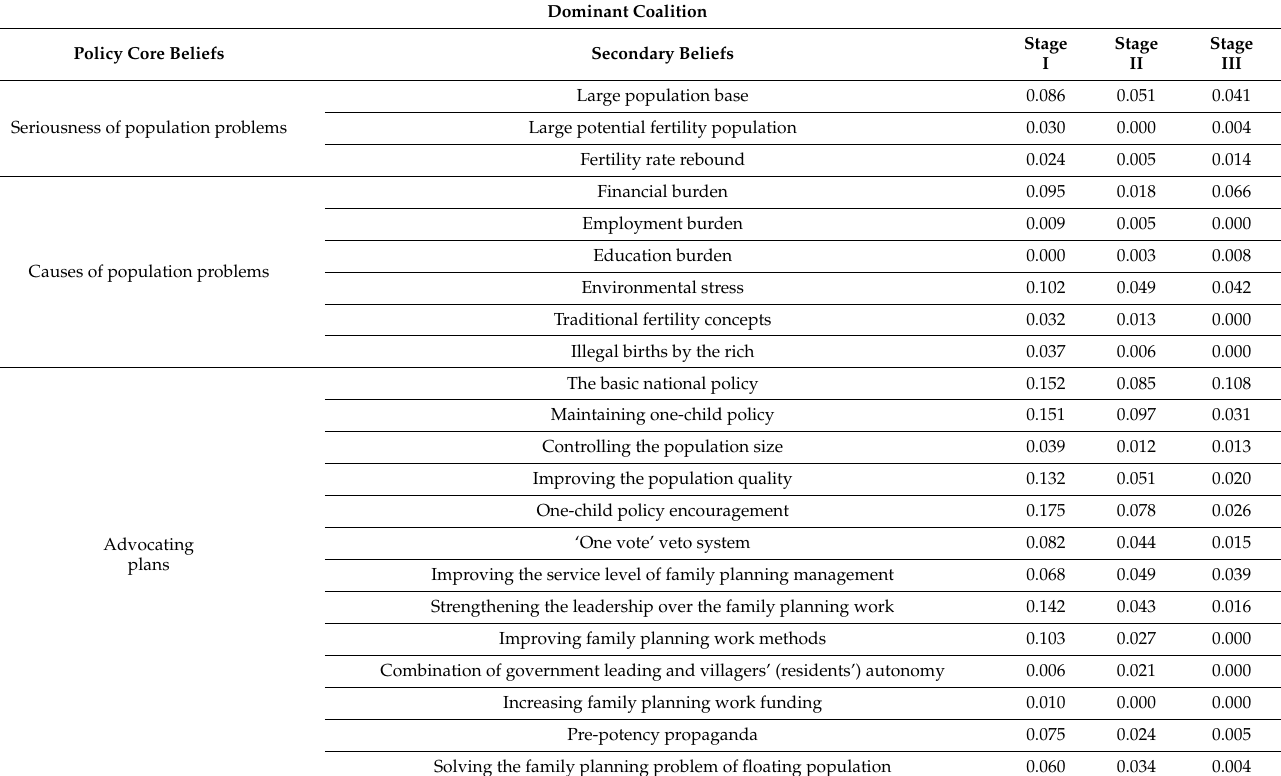
Table 7. Degree centrality analysis of discourse concept from the dominant